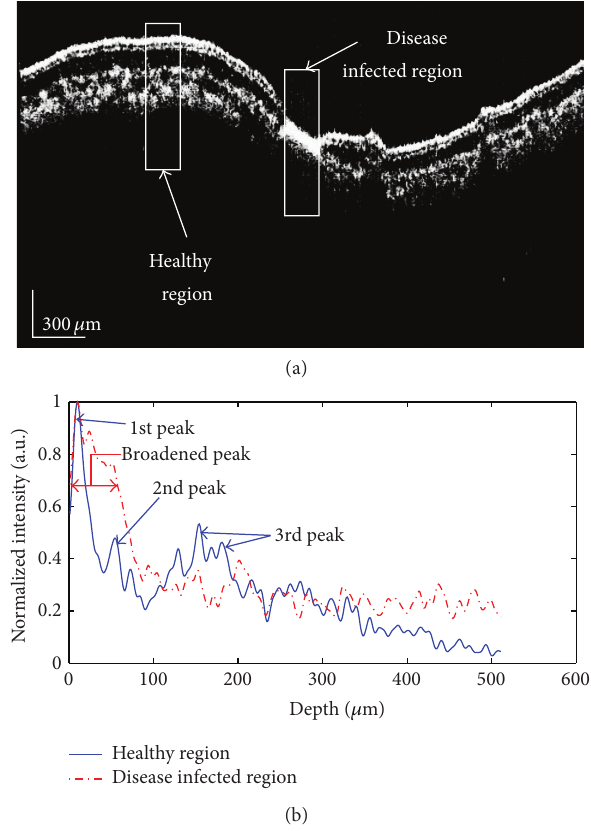
Figure 5: A-scan analysis of healthy and disease infected regions of leaf. 2D OCT image of disease infected leaf is shown in (a) marked with healthy region and disease infected region used for A-scan analysis and its corresponding A-scan analysis are shown in